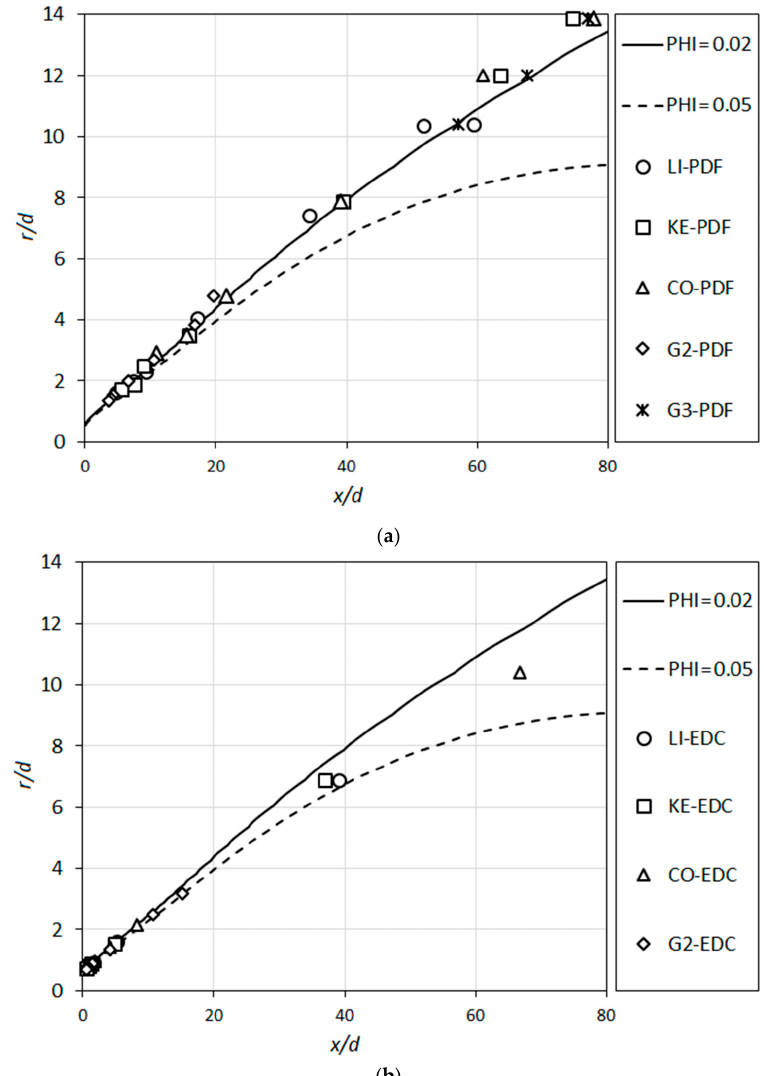
Figure 15. Isolines of φ = 0.02 and φ = 0.05 predicted for non-combusting flow compared with the predicted flame root positions based on different detailed reaction mechanisms, using the ( a ) PDF turbulent combustion model and the ( b ) EDC turbulent combustion model.